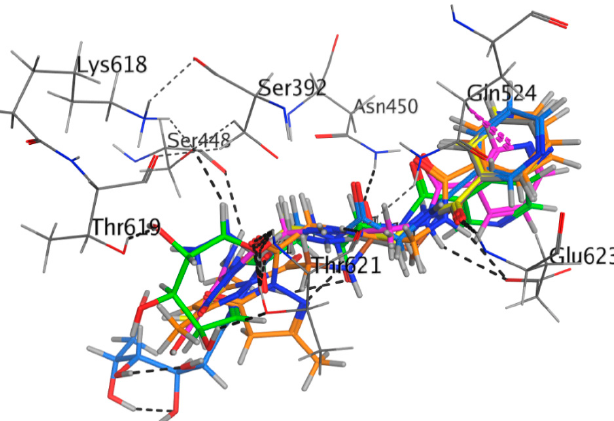
Figure 1. Compounds 4 to 11 superimposed by their non-covalent-docking poses in the active site of PBP3 pocket.